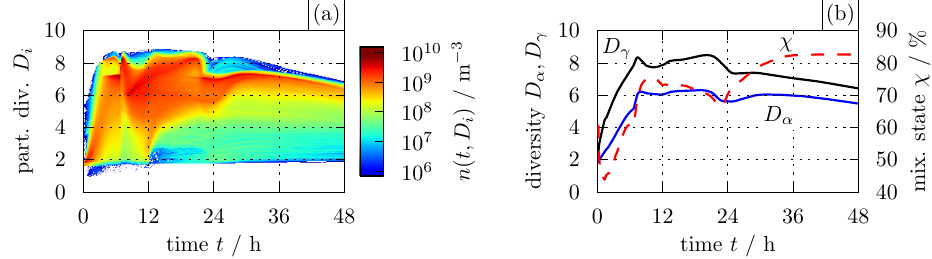
Fig. 7. Diversity and mixing state evolution for BC-containing particles in the urban plume case. (a) Distribution of per-particle diversity D i as a function of time. (b) Time series of average particle diversity D α , population diversity D γ , and the mixing state index χ .